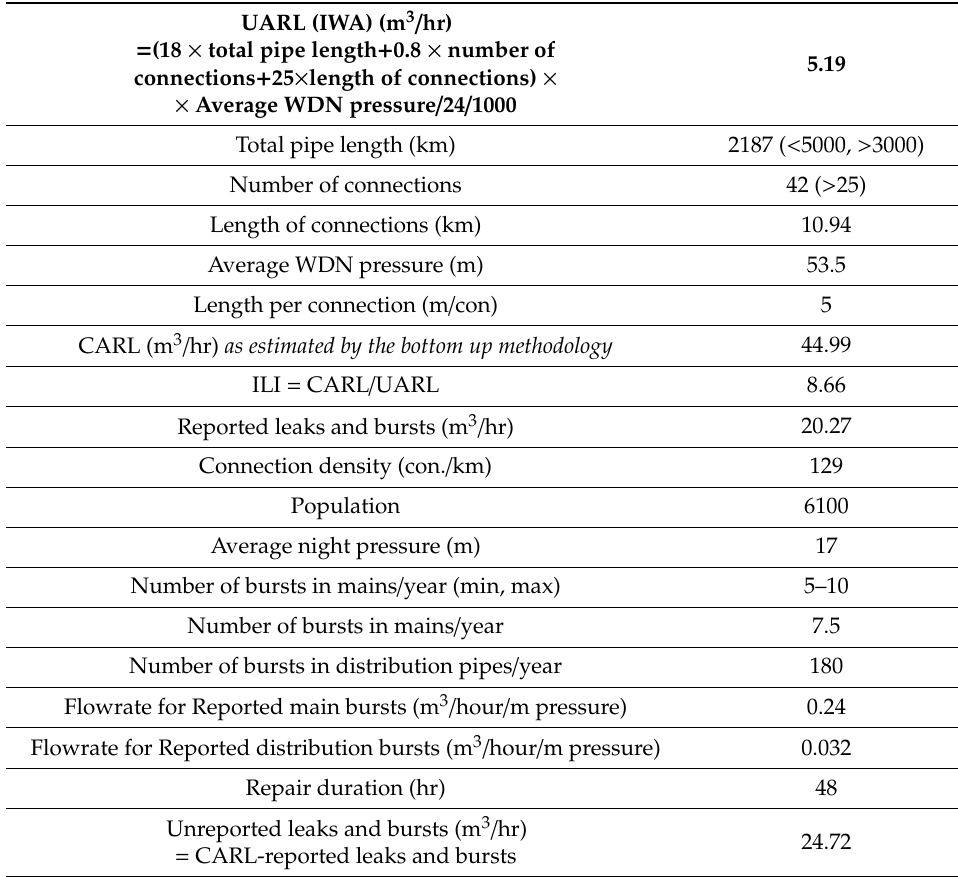
Table4. CharacteristicsofSkiathosWDNusedfortheestimationofbackgroundlossesandinfrastructure leakage index (ILI) for the base